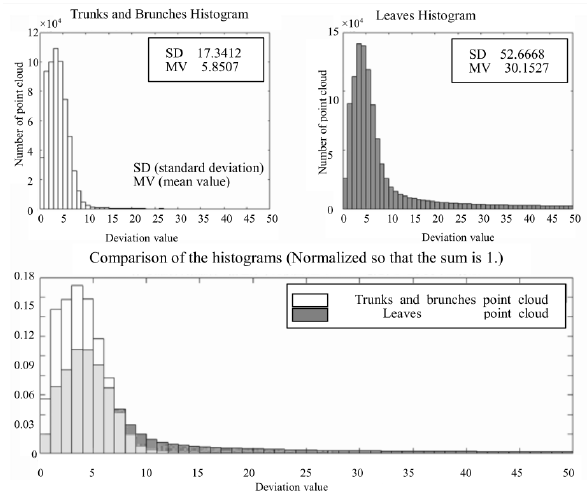
Figure 3. Deviation histogram which a tree point cloud obtained by a TLS is divided into segments, with the radius and direction of each segment locally approximated and reconstructed as a continuous cylindrical model. By using this method, it is possible to construct a 3D tree model with small branch details that are difficult to generate automatically (Åkerblom, 2015)(